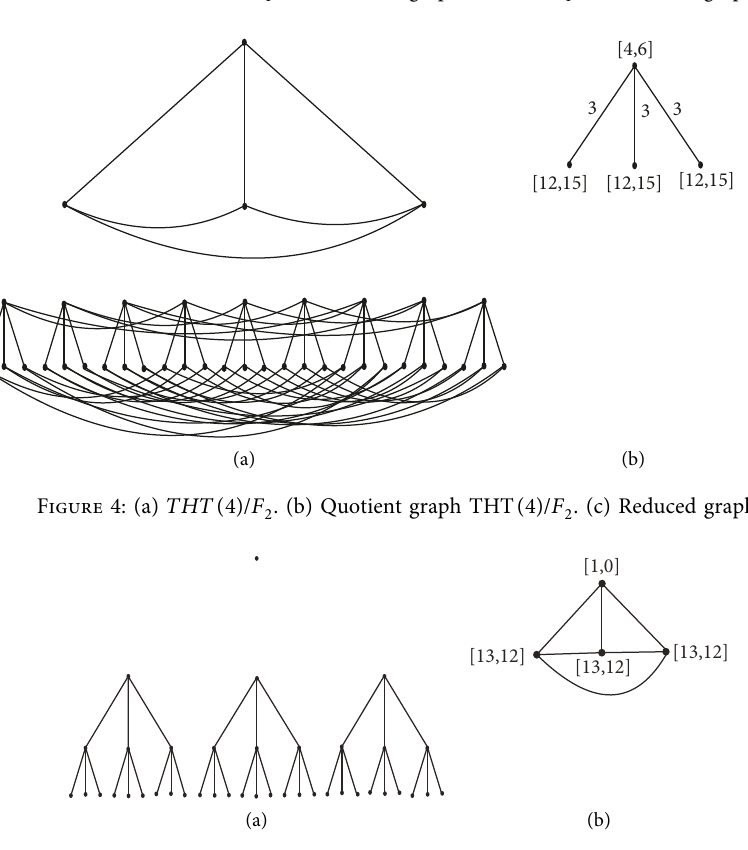
. (c) Reduced graph. 1